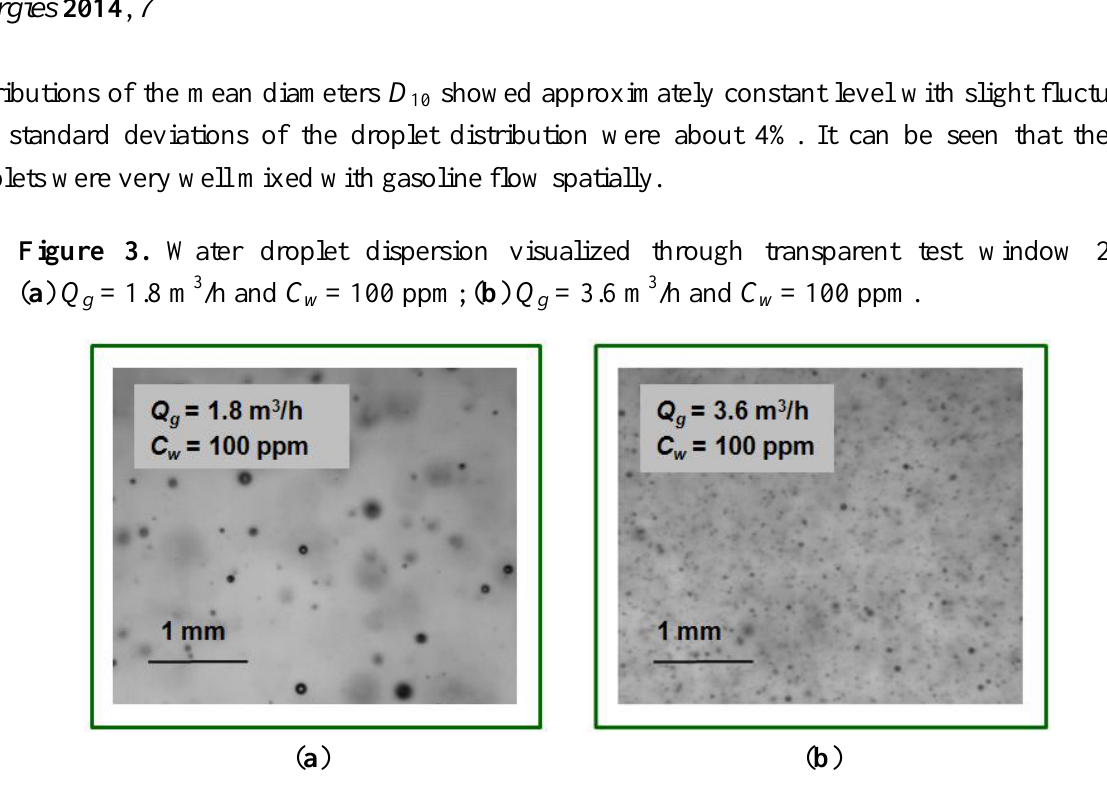
Figure 4. Distribution of arithmetic mean diameter of water droplets along transverse direction of gasoline pipe